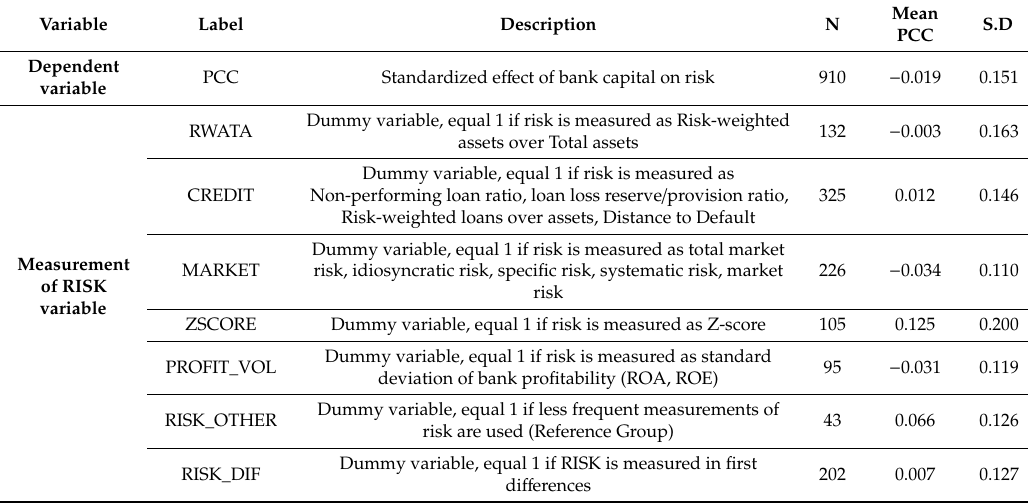
Table 3. Main variables in meta-regression